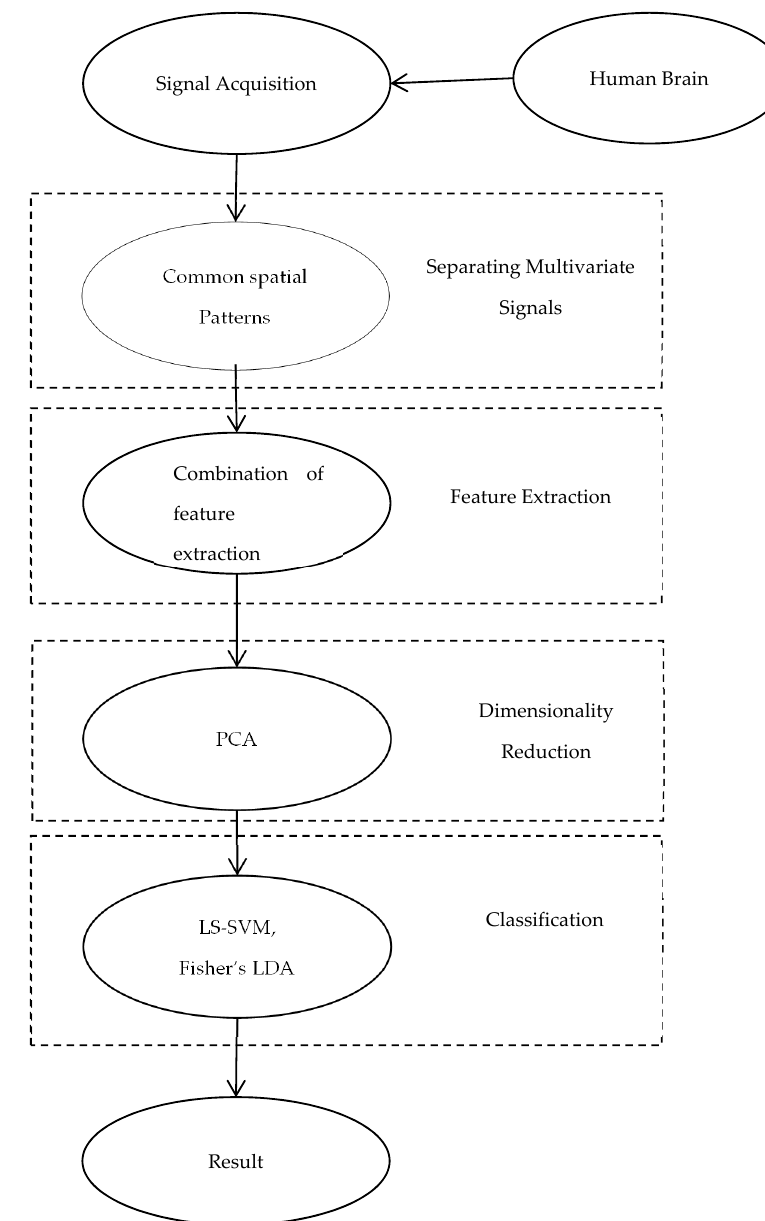
Figure 1. A block diagram of proposed